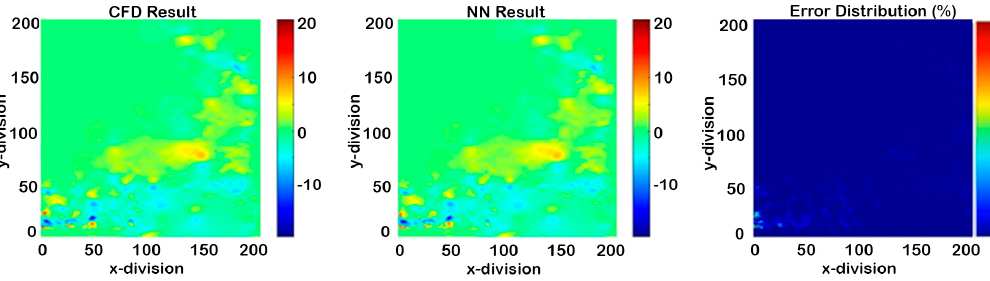
Figure 23. Cascading results of Model Ⅱ for pressure (seven time-steps after deployment).